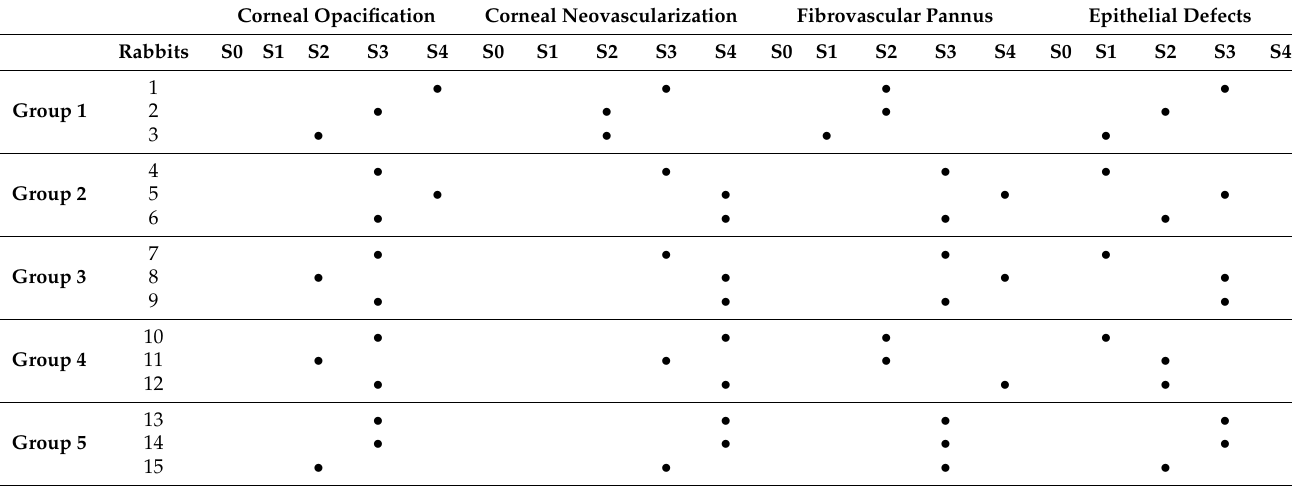
Group 1: only medical treatment (control group), Group 2: fibrin-PRGF membrane cultured with autologous rabbit LEPCs, Group 3: fibrin-PRGF membrane cultured with heterologous rabbit LEPCs, Group 4: fibrin-PRGF membrane SLET and Group 5: fibrin-PRGF membrane without rabbit cultured LEPCs. PRGF: Plasma Rich in Growth Factors, LEPCs: Limbal Epithelial Progenitor Cells, SLET: Simple Limbal Epithelial